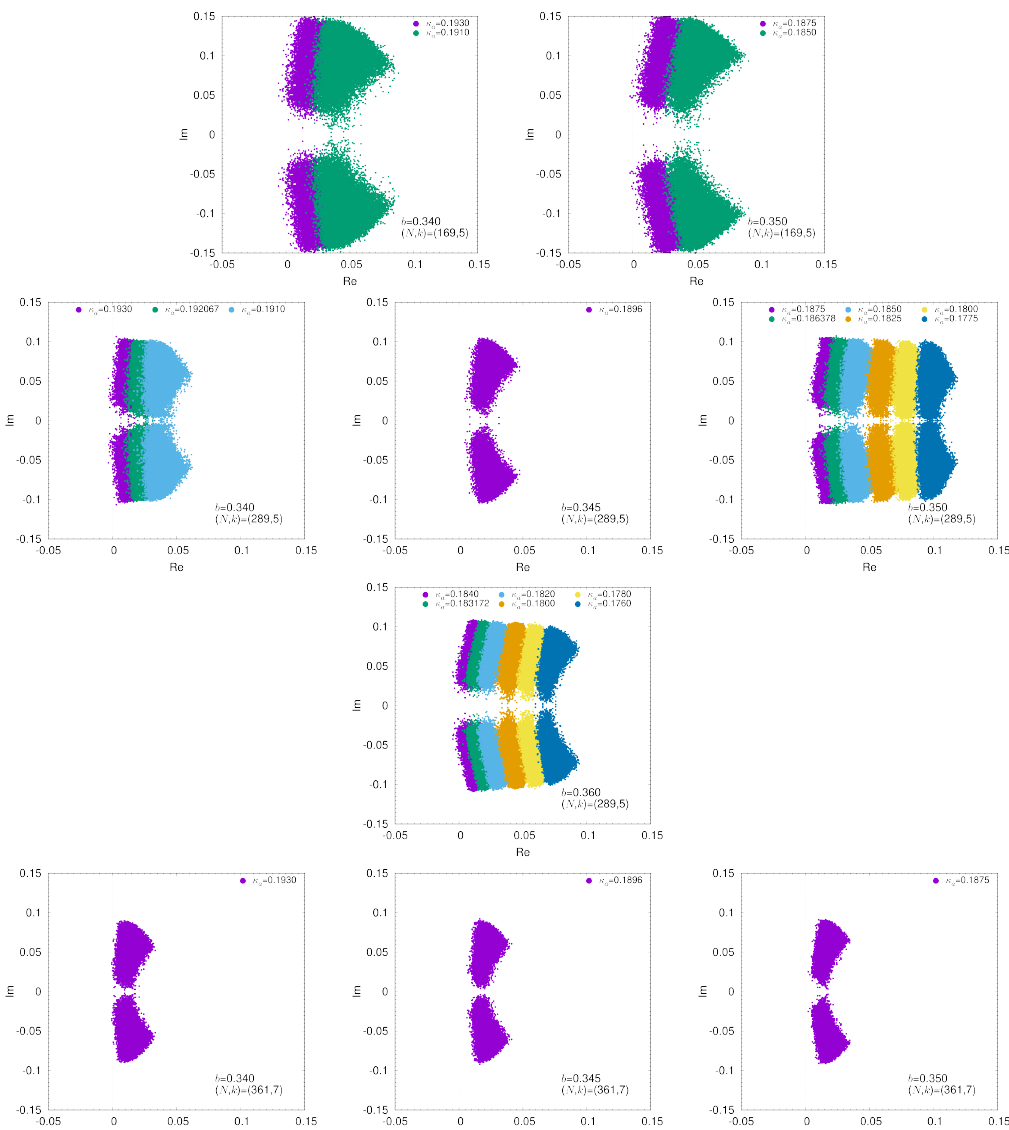
Figure 1. We display in the complex plane and for a subset of our simulation parameters at various values of N , the 100 eigenvalues of the Wilson-Dirac operator D W closest to